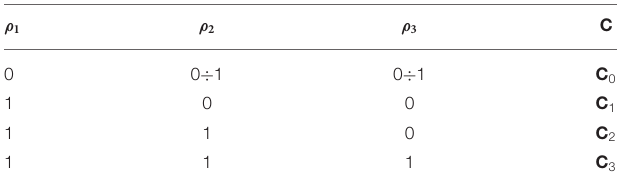
TABLE 1 | Macroscopic stiffness matrix retrieved by Equation (5) depending on the values of ρ i . ρ 1 ρ 2 ρ